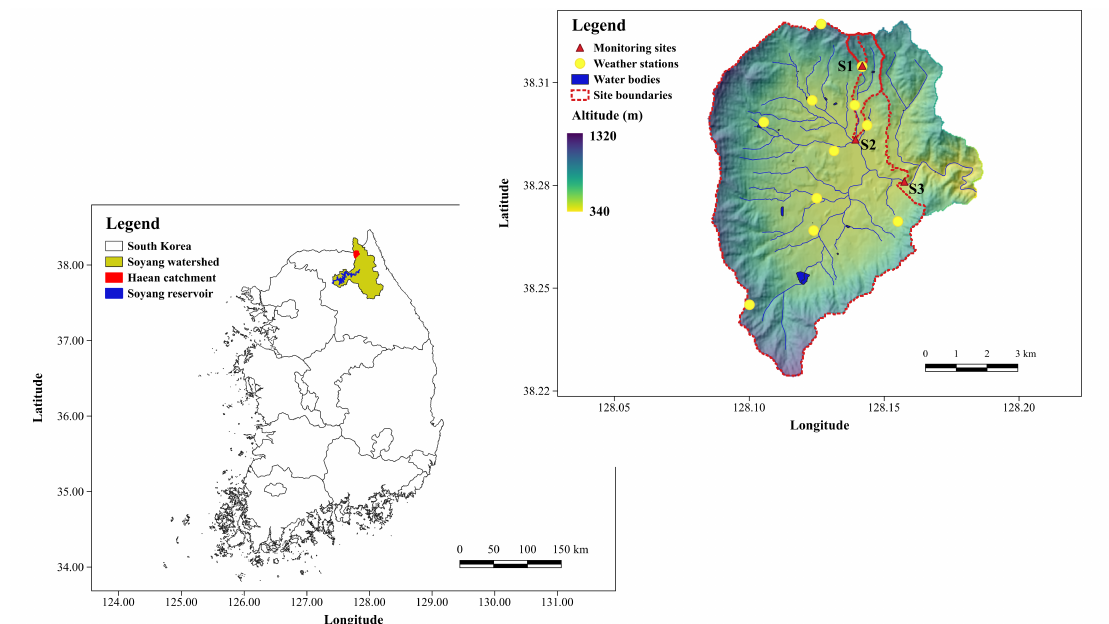
Figure 1. General description of the study area. Locations of the Soyang lake watershed and Haean catchment in South Korea are described in the lower left figure. In the upper right figure, the topography and stream networks of the study area, with the monitoring sites (red triangles) and weather stations (yellow circles) used for the DMMF model are